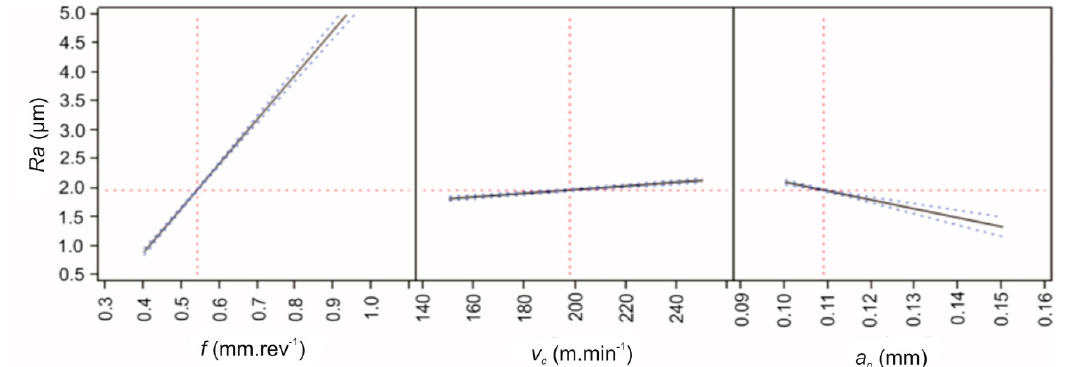
Figure 5. Prediction of the dependence of the parameter Ra on feed rate f , cutting speed v c and depth of the cut a p .